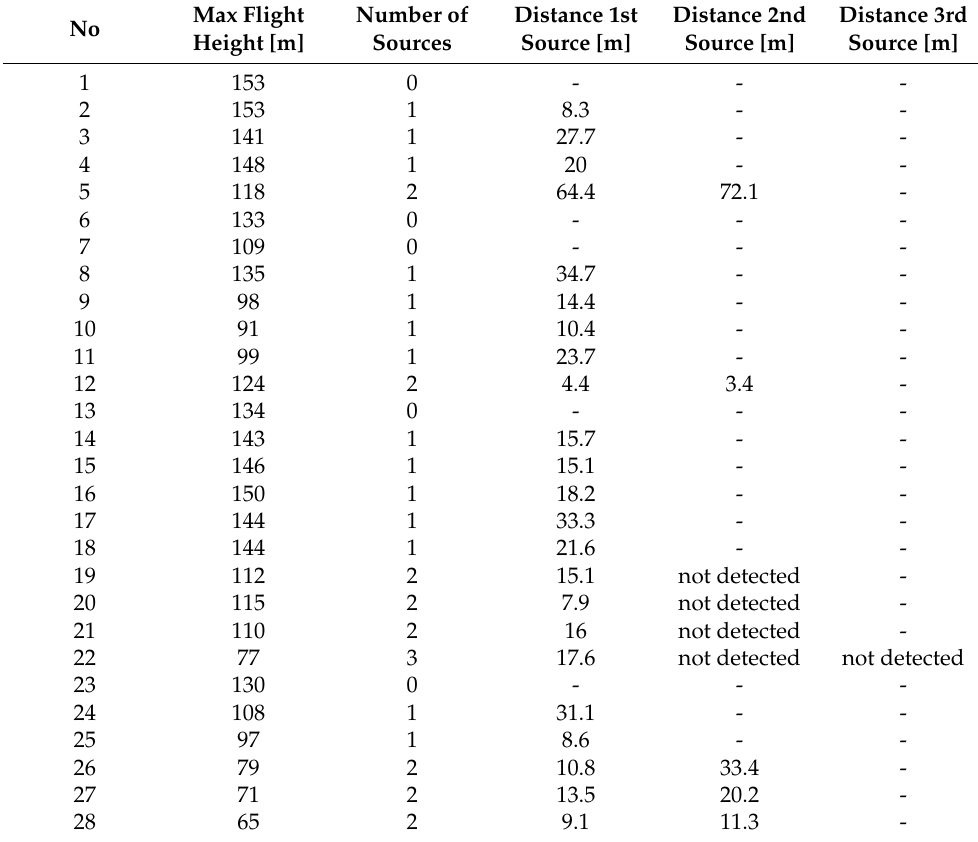
Table 3. Localization